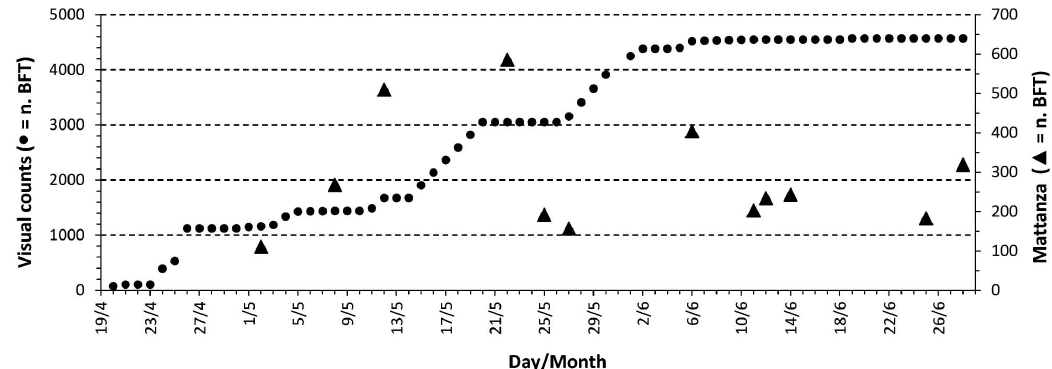
Fig. 3. – Plot representing the cumulative number of bluefin tuna in the time range April 20-June 28, 2010 (Visual counts, l ; Mattanza , p ). Data from visual counts have been recalculated using a correction factor derived from the relationship between expected and observed values. The number of specimens caught by mattanza was added to the number of bluefin tuna estimated by visual counts on the corresponding day.